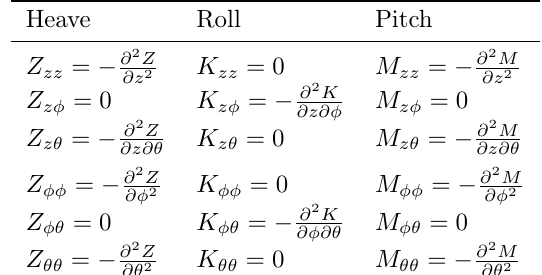
Table 1: Main characteristics of the container ship Quantity Sym. Value